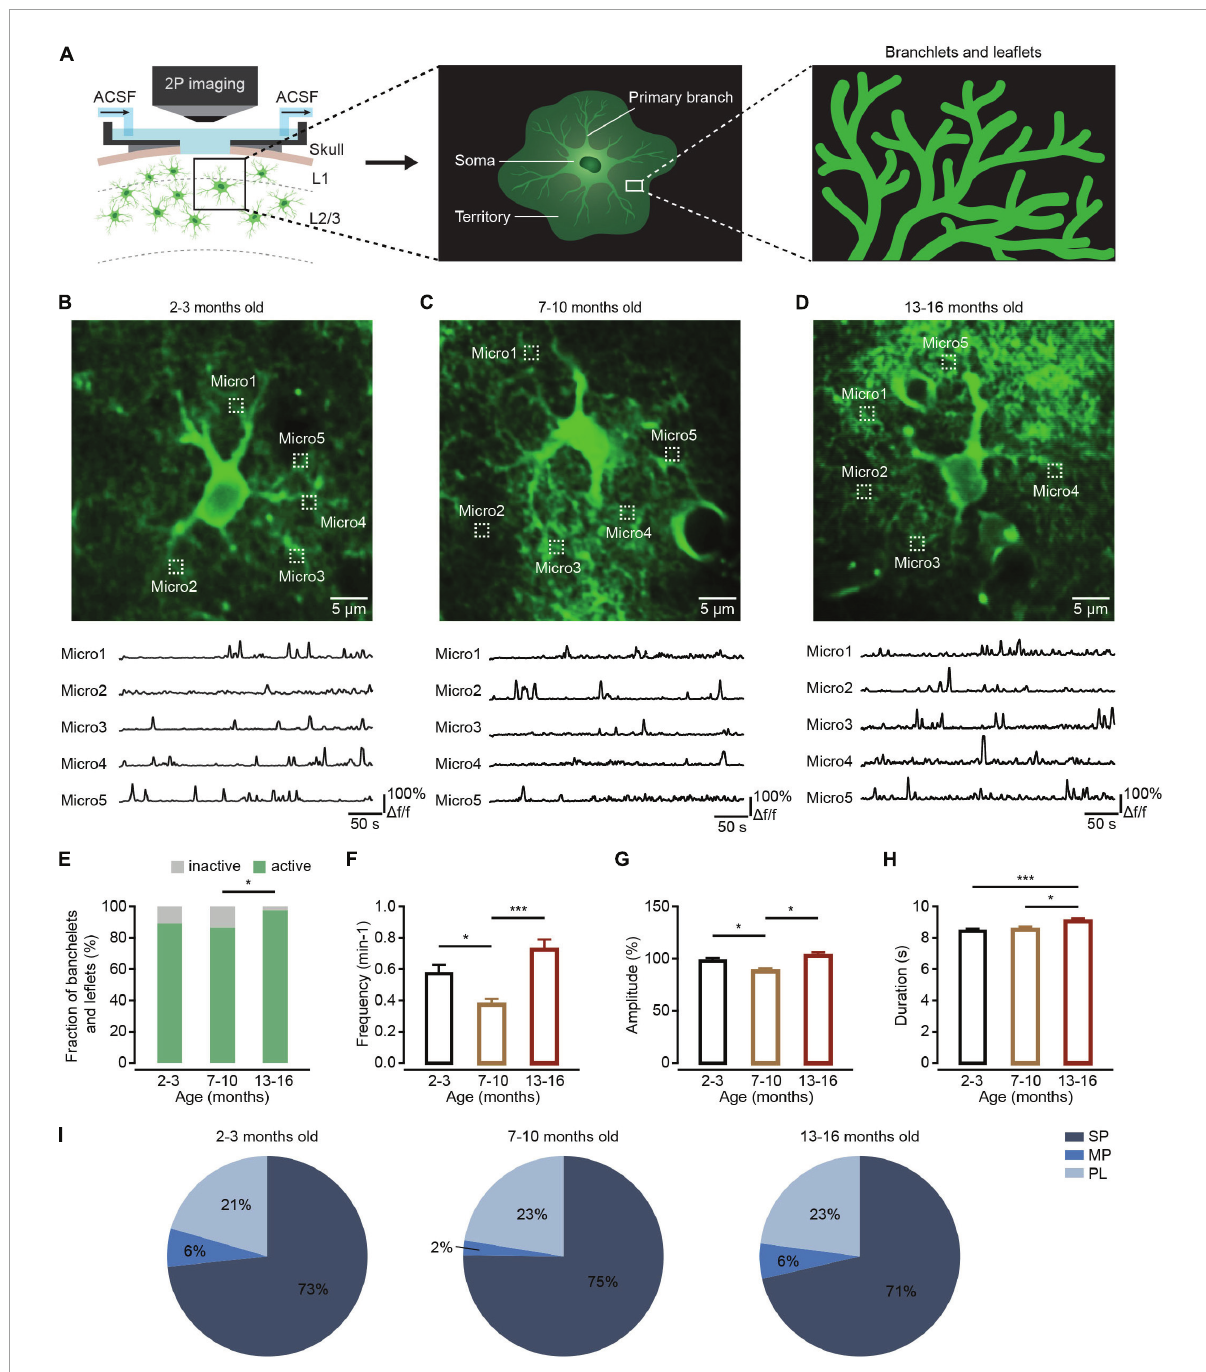
FIGURE2 Ca 2 + transient changes within branchlets and leaflets of cortical astrocytes during brain aging. (A) Schematic of two-photon Ca 2 + imaging of astrocytic branchlets and leaflets expressing GCaMP6f. (B–D) Top, representative two-photon images of GCaMP6f-labeled ROIs of branchlets and leaflets in the 2–3-month-old ( B ; imaging depth, 172 µ m), 7–10-month-old ( C ; imaging depth, 151 µ m), and 13–16-month-old groups ( D ; imaging depth, 134 µ m). Regions of branchlets and leaflets are outlined by white dashed squares. Below are example traces of spontaneous Ca 2 + transients from each ROI. (E) The fraction of active branchlets and leaflets within the 2–3-month-old ( n = 119 ROIs from six mice), 7–10-month-old ( n = 112 ROIs from seven mice) and 13–16-month-old groups ( n = 88 ROIs from six mice). All groups: χ 2 = 7.6671, P = 0.0216; the 2-3-month-old group versus the 7–10-month-old group: P = 1.000; the 2–3-month-old group versus the 13–16-month-old group: P = 0.0529; the 7–10 month-old group versus the 13–16-month-old group: P = 0.0154, * P < 0.05, χ 2 -test followed by Bonferroni correction. (F) Bar graphs summarizing the frequencies of Ca 2 + transients within active astrocytic branchlets and leaflets of the 2–3